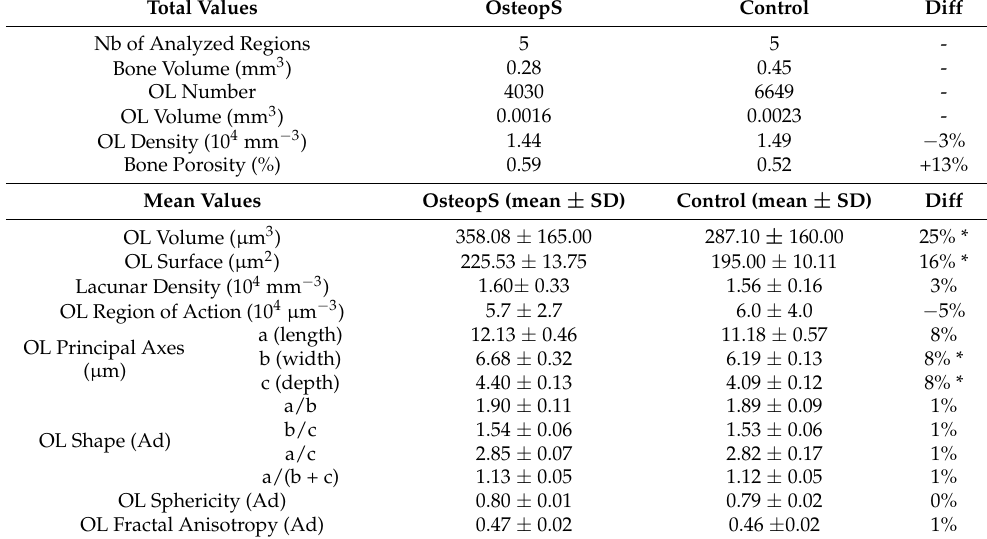
Data are reported as mean ± standard deviation. “OsteopS” refers to osteoporotic subject, “Diff” stands for difference between the osteoporotic subject and the control, and “Ad” refers to a-dimensional. * indicates a p value < 0.05.